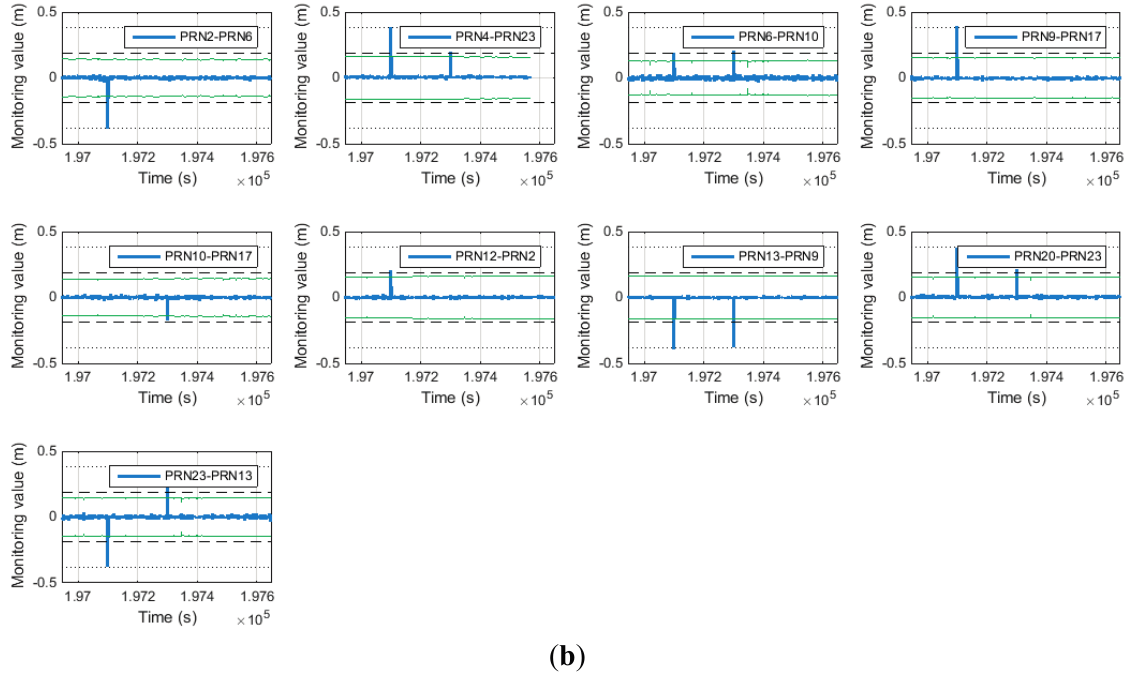
Figure 10. ( a ) Cycle slip detection result of general SD (above); ( b ) Cycle slip detection result of proposed SD (below).